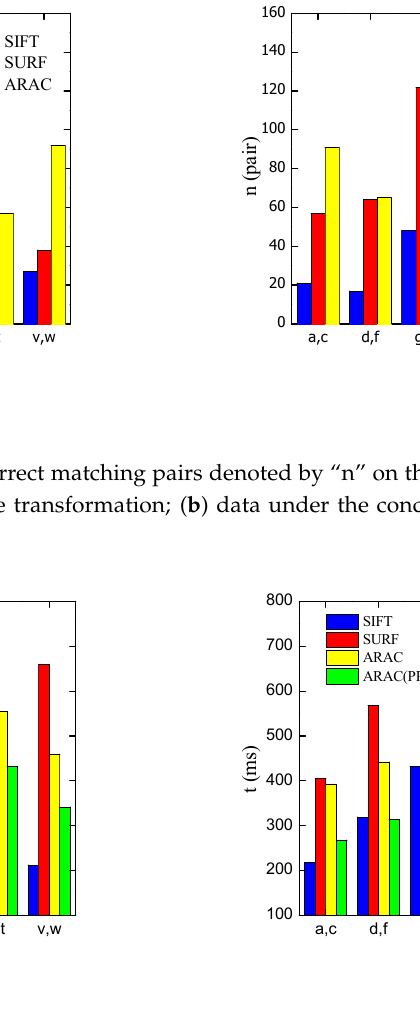
Figure 22. Comparison of total extraction and matching time denoted by “t” on the vertical axis. ( a ) data under the condition of illumination change and affine transformation; ( b ) data under the condition of illumination change and large-angle affine transformation.